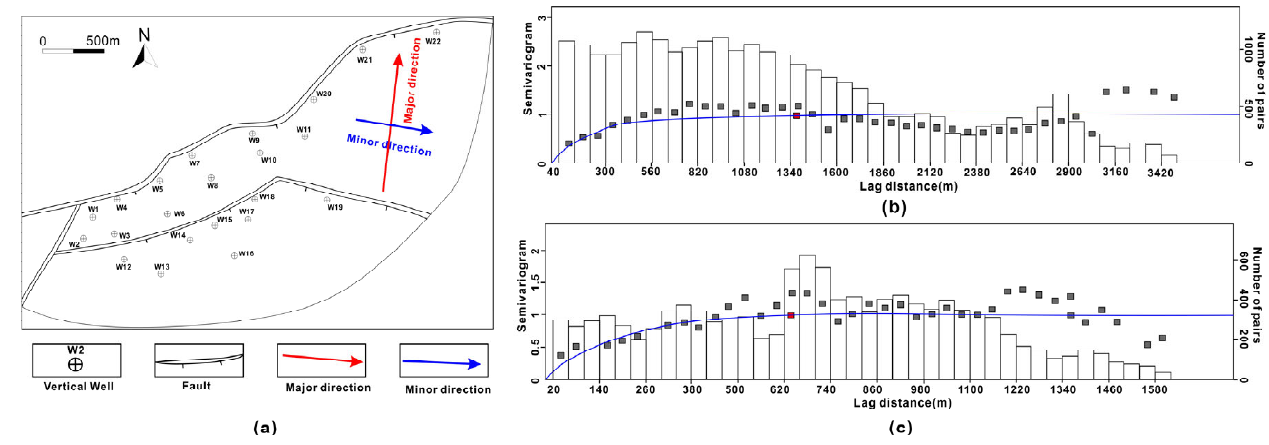
Figure 12. ( a ) Major and minor directions in study aera. ( b ) Variogram of porosity in the major direction. ( c ) Variogram of porosity in the minor direction. The blue lines represent the fitting variograms using the spherical model (Squares indicate the number of sample points at different distances).